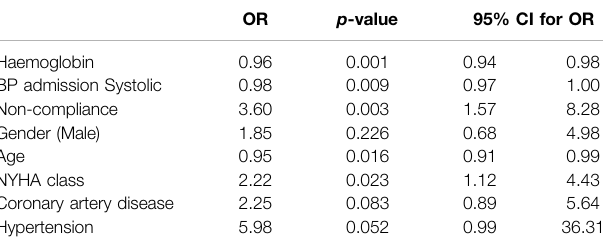
TABLE 10 | Multiple logistic regression for the factors associated within 90 days readmission.